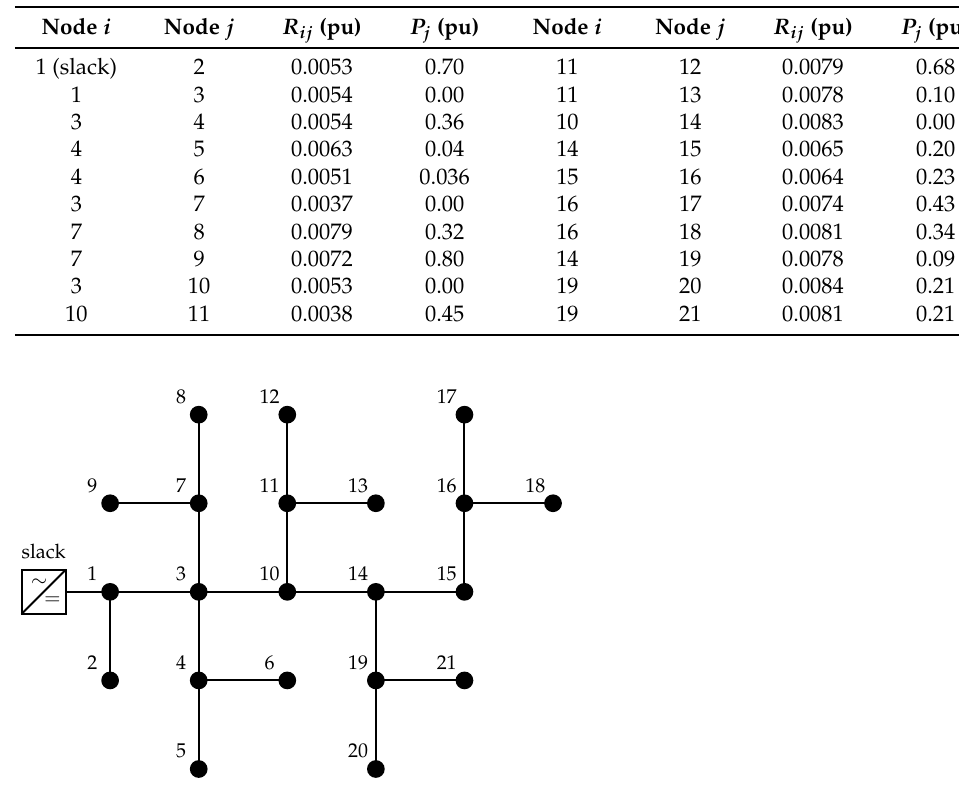
Table 1. Parametric information of the 21-bus grid (the power and voltage bases are 1 kV and 100 kW).